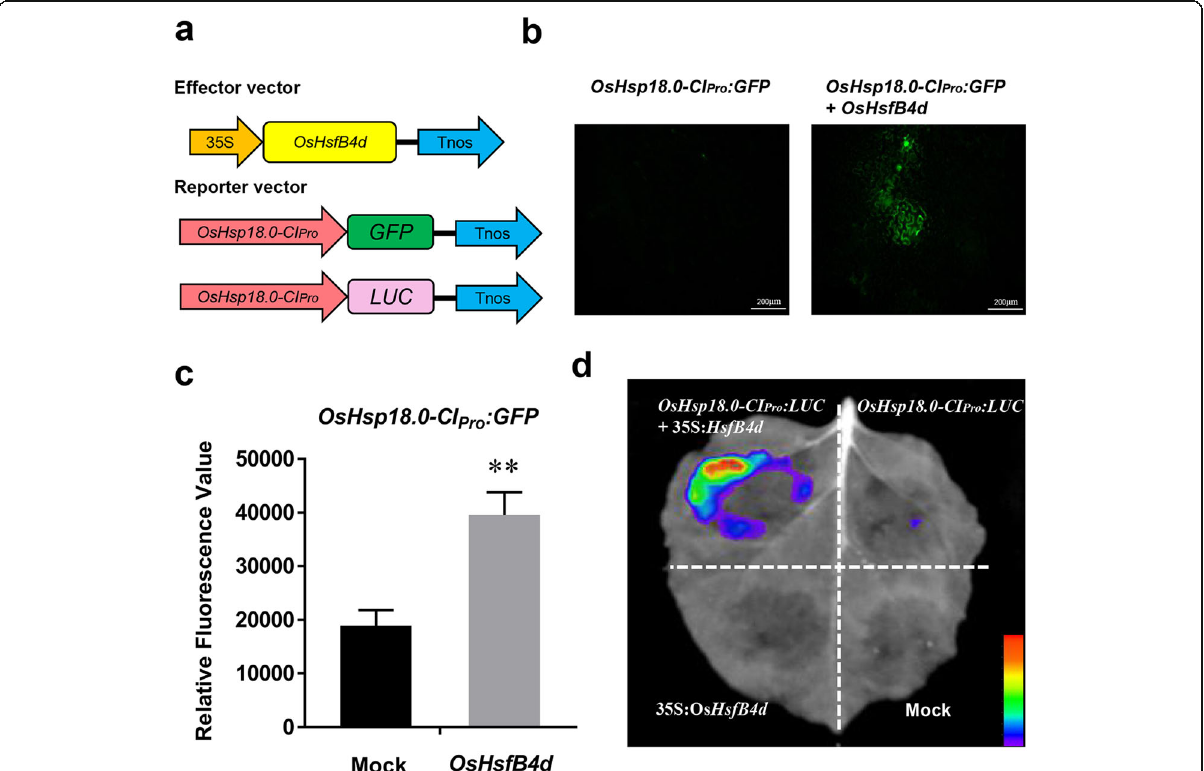
Fig. 2 Fluorometric assays of GFP or LUC driven by OsHsp18.0-CI promoter constructs. a Diagram of the constructs of OsHsfB4d and the OsHsp18.0-CI promoter. b GFP fluorescence of the OsHsp18.0-CI promoter DNA construct (OsHsp18.0-CI Pro :GFP). Coexpression with or without the OsHsfB4d in N. benthamiana . Images were photographed at 2 d after infiltration. Bar = 200 μ m. c Quantitative analysis of the fluorescence intensity. The results are presented as the average fluorescence intensity using ZEN software. The experiments were repeated three times. ** indicates significant differences according to Fisher ’ s least-significant difference test ( P < 0.01). d Luciferase assay of the co-expressed OsHsfB4d and the promoters of OsHsp18.0-CI (OsHsp18.0-CI Pro :LUC). Mock represents the 10 mM MgCl 2